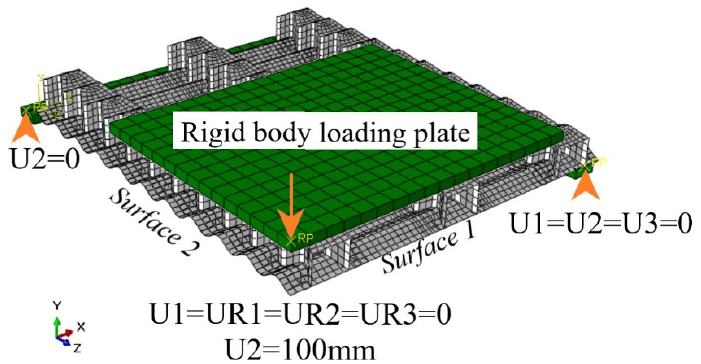
Figure 6. Symmetric FE model of the tested two-way deck.